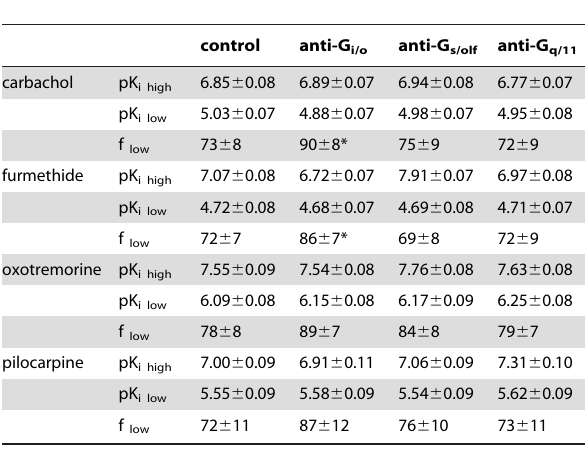
Table 8. Effects of IgG antibodies directed against a -subunits of individual subtypes of G-proteins on binding parameters of muscarinic agonists in membranes of M 2 CHO cells with reduced expression of G i/o G-proteins by siRNA.